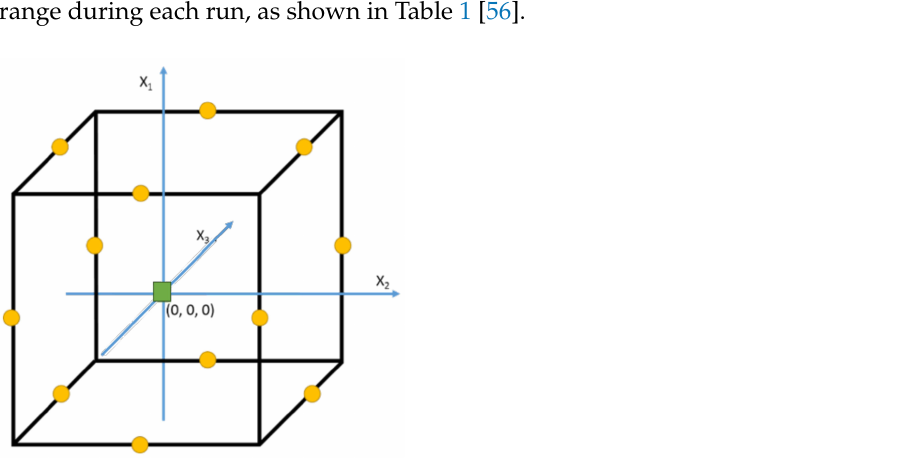
Figure 4. Graphical representation of three factor BBD. Circles are experimental points and square is the central point. X 1 , X 2 , and X 3 are the factors